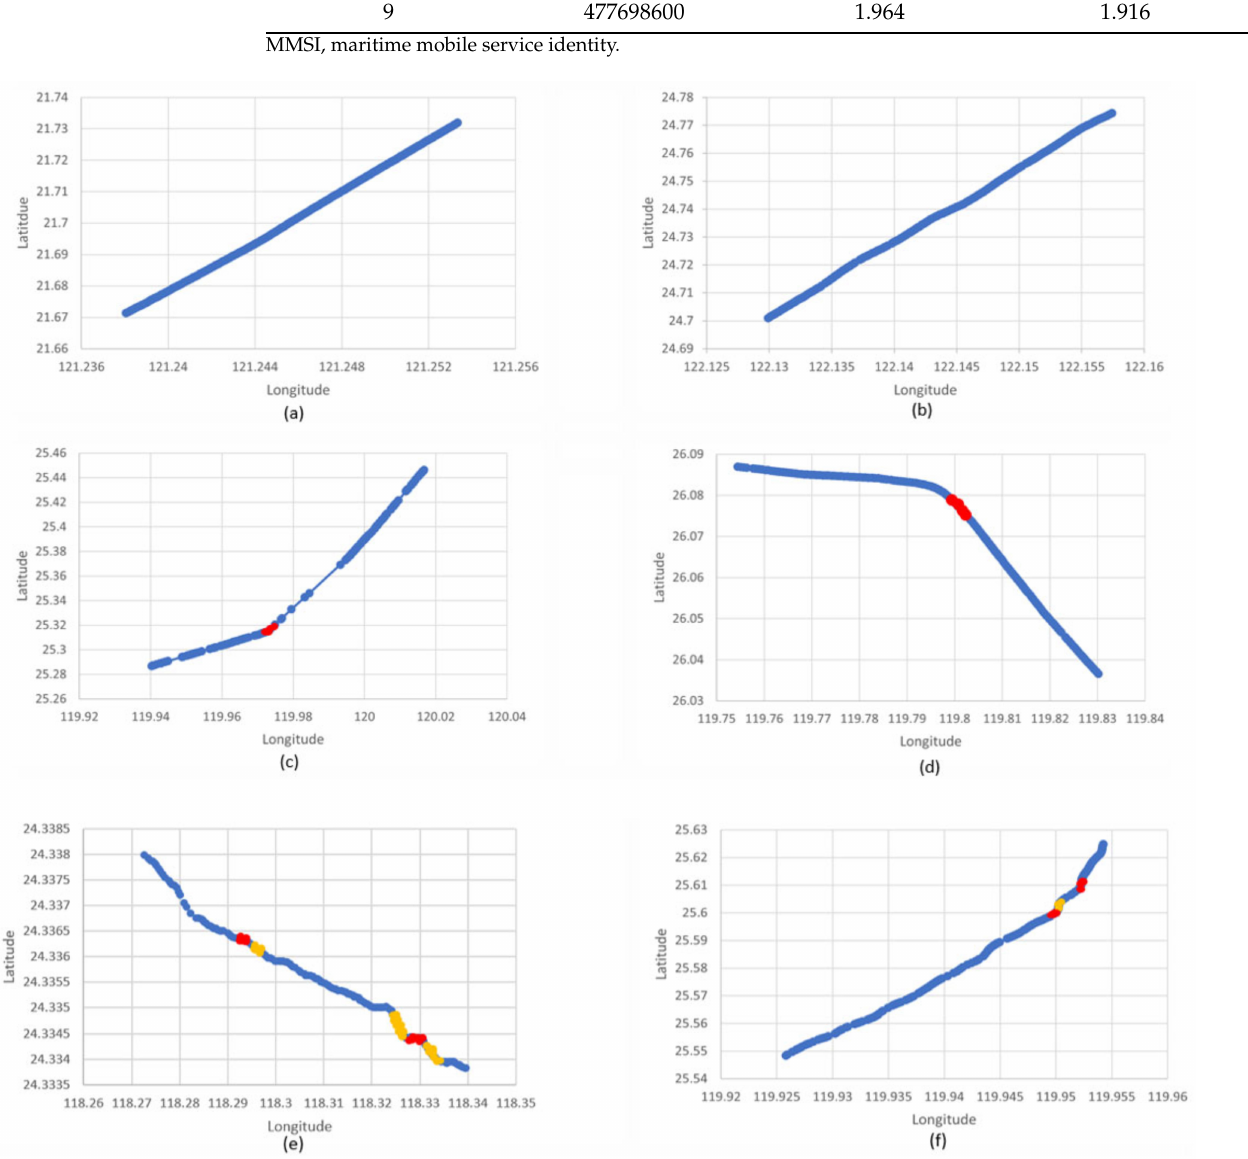
Figure 5. Verify The COG transforms of vessel ( a ) 411747900; ( b ) 215280000; ( c ) 477118100; ( d ) 413484000; ( e ) 413697130; ( f ) 413705580. Red line, left turn; Yellow line, right